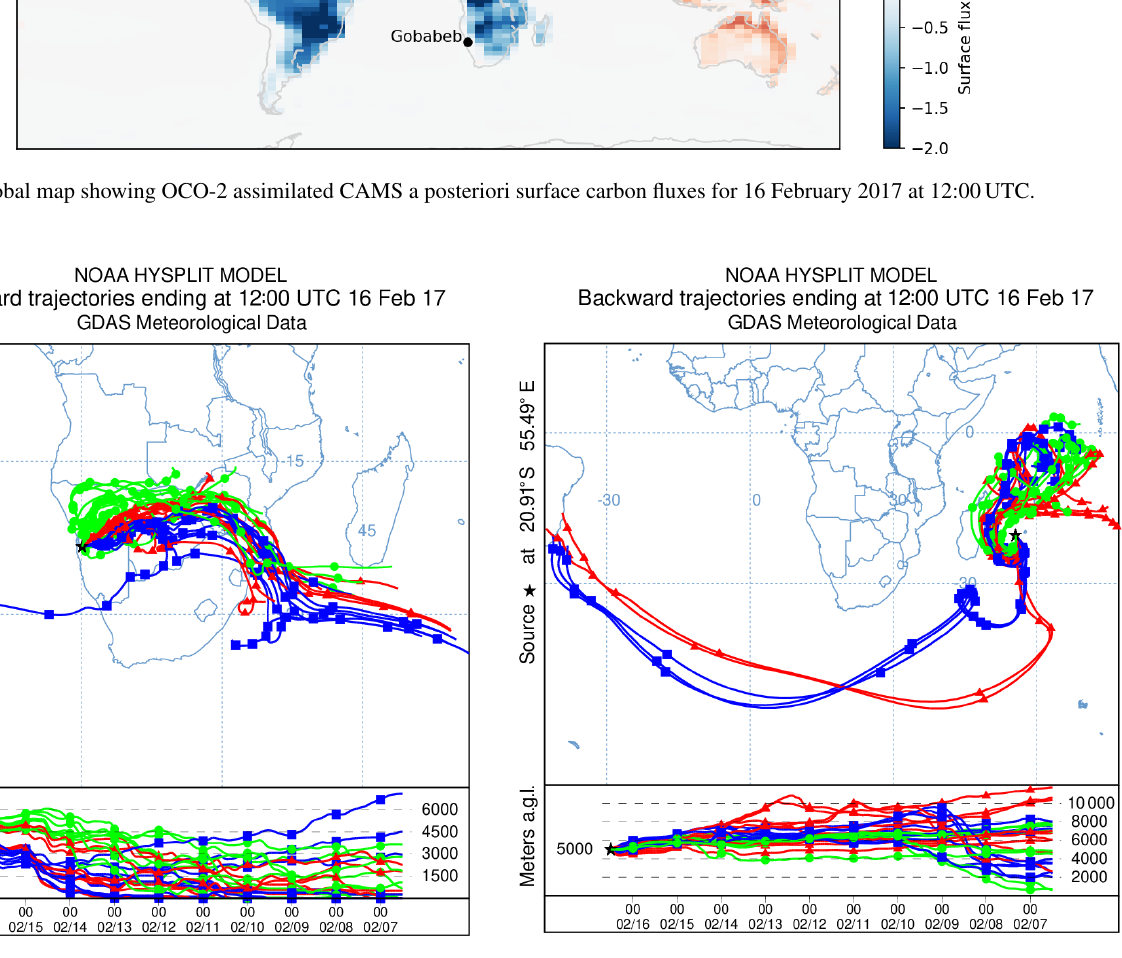
Figure 18. NOAA HYSPLIT backward trajectory ensemble simu- lations on 16 February 2017. The endpoint of the backward trajecto- ries is the COCCON Gobabeb station, 5000m above ground level. The colors and symbols are used to make the different trajectories of the ensemble distinguishable.